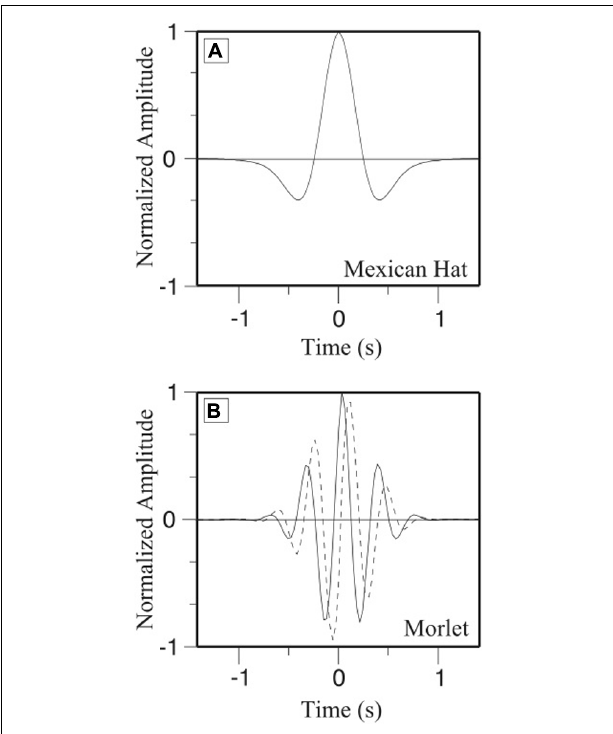
FIGURE 3 |Temporal representation of (A) the Gaussian (Mexican Hat) and (B) the Morlet analyzing functions.